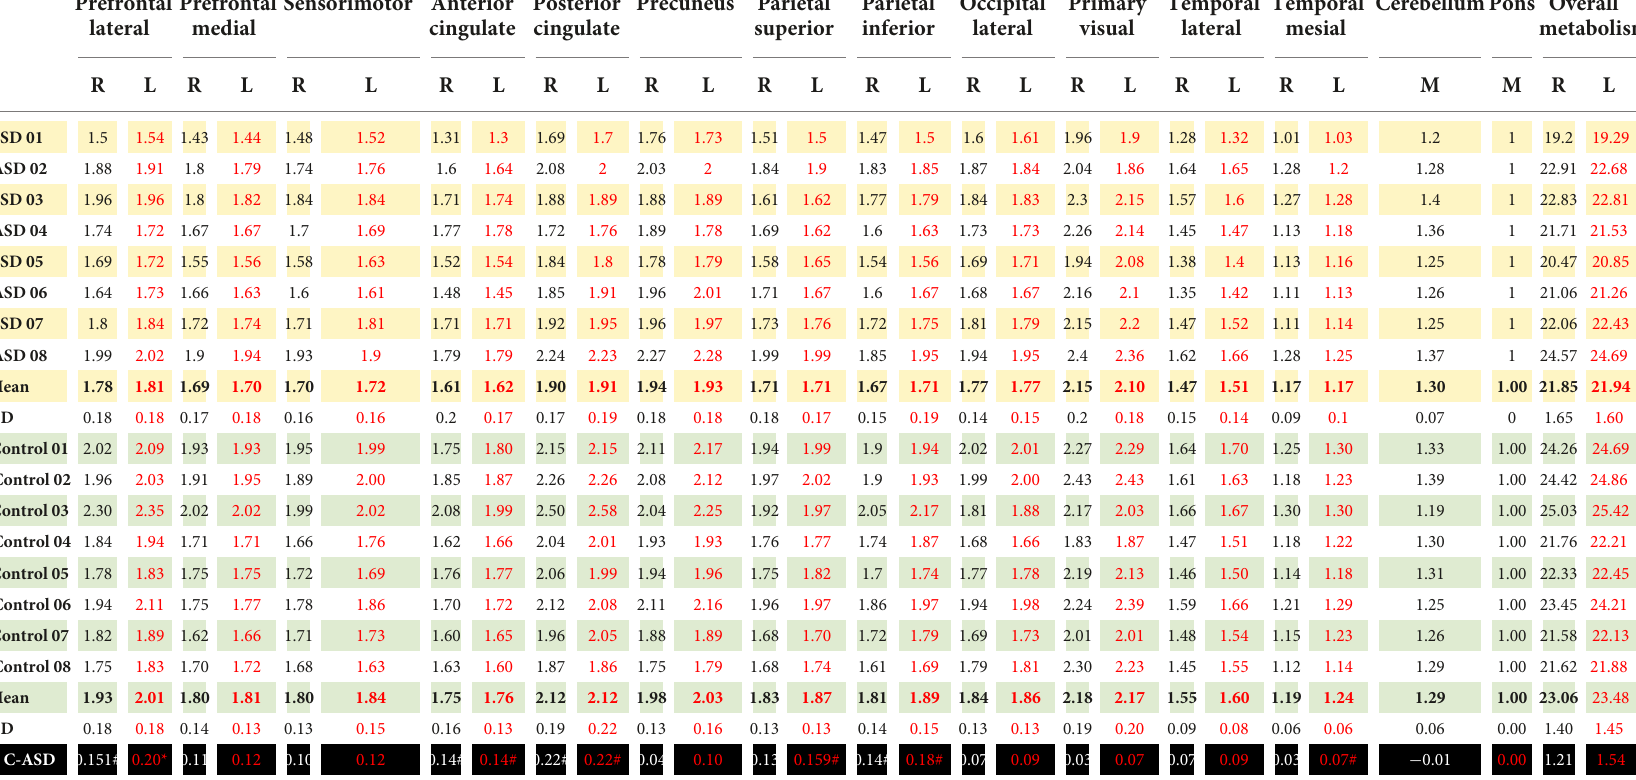
TABLE 3 Brain glucose metabolism in the right and left region of interest presented as ratio of brain glucose metabolism using Q.Brain software in ASD ( n = 8) and control ( n =